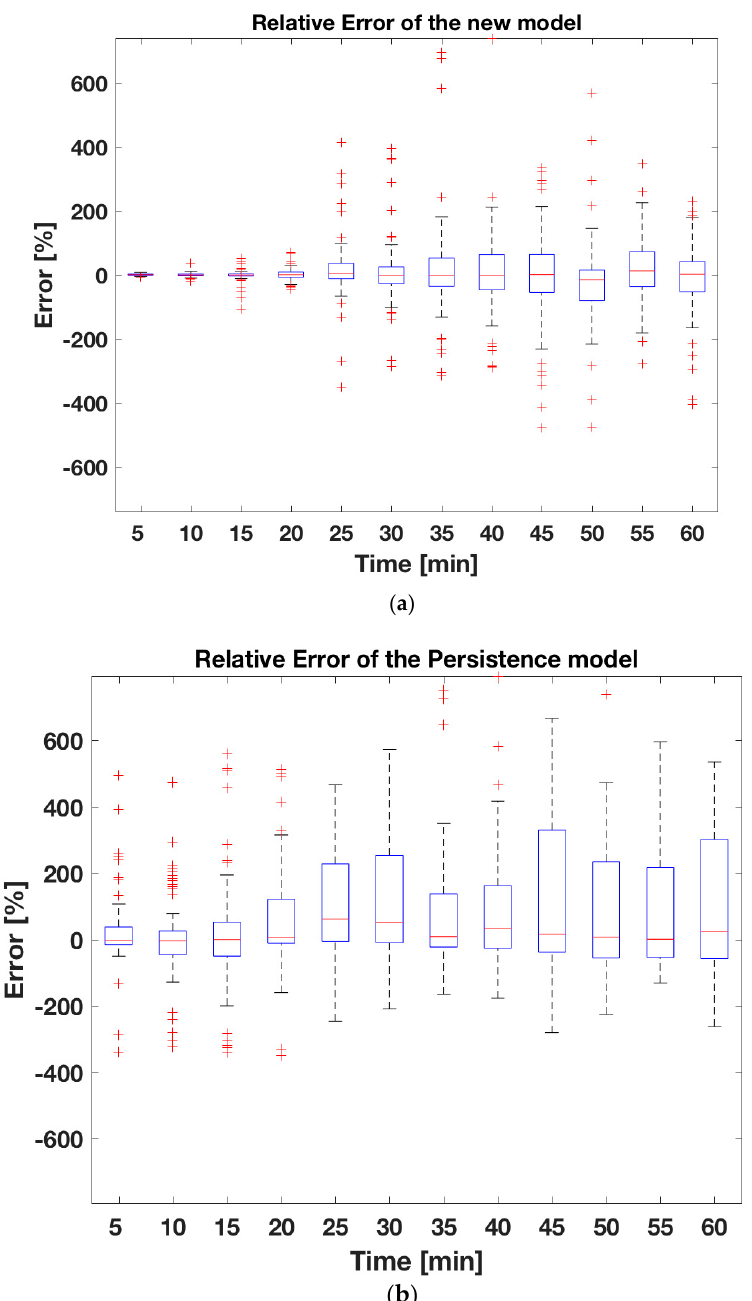
Figure 6. The relative deviation boxplot of the simulation derived for different time horizons. The symmetry in 50% of the data decreases as soon as the program receives information from the last picture and increases when the program does not receive information from the last picture. ( a ) corresponds to the new ANN. Here, there are narrower interquartile ranges for higher sample sizes, but the numbers of outliers (+) are lower than in ( b ). ( b ) corresponds to the persistence model. Of the data, 50% is not exactly located in the middle, and the 25% and 75% levels of the data deviation are higher than in ( a ).